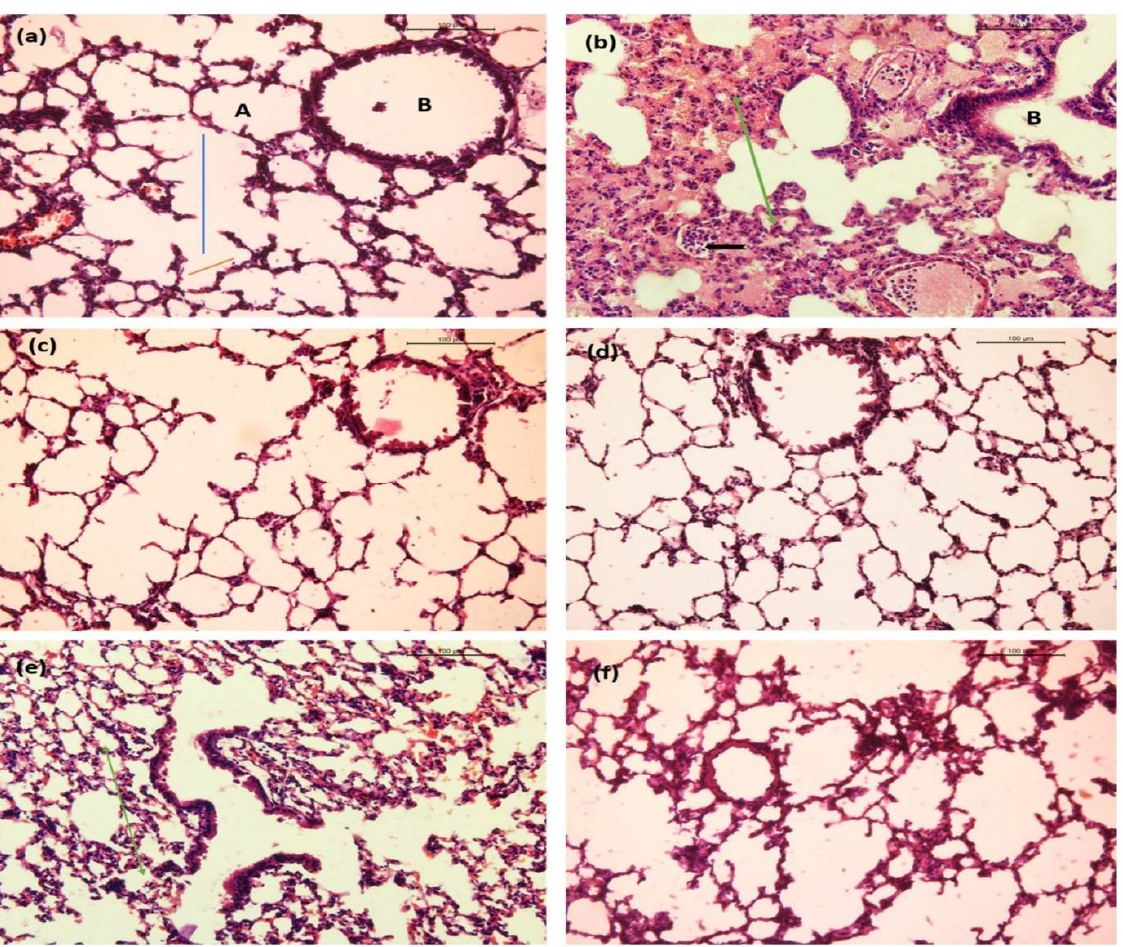
Figure 17. Images represent the BGG protection on LPS-induced sepsis model in mice. Hematoxylin and eosin (H&E)-stained lung sections from mice treated with ( a ) saline showing normal and dis- tinct respiratory bronchiole (B), alveolus (A), alveolar duct (blue line), and alveolar sac (red line). ( b ) Lipopolysaccharide (LPS) endotoxin showing severe degenerative alterations in the lung with ruptured bronchiole (B), interstitial and intraalveolar hemorrhage and alveolus atelectasis and fu- sion (green arrow), inflammatory cell infiltration (arrowhead). ( c , d ) BGG 20 mg/kg and 40 mg/kg showing no significant pathological alteration. ( e ) LPS+ BGG 20 showing moderate alveolar damage with reduction of interalveolar septum thickening (green arrow). ( f ) LPS + BGG 40 showing mild thickening of some alveolar-capillary with intact reparatory bronchiole. Scale bars: 100 μm ( f ) Meas- uring extracellular cytokine interleukins by CBA bead assay analyzed by using flow cytometry in mice serum. 2.10.4. BGG Reduces the LPS-Induced Inflammatory Response in the Sepsis Model In vivo anti-inflammatory activity of BGG was evaluated in the BALB/c sepsis model. As shown in Figure 18, the in vivo study showed a significant increase in IL-6, IFN-γ, TNFs, IL-17A, and IL-10 expression in serum of LPS (5 mg/kg)-treated mice, and no con- siderable changes in IL-2 and IL-4 levels were observed. The treatment with 20 mg/kg of BGG showed a mild decrease in IFN-γ and TNFs levels, whereas when treated with 40 mg/kg of BGG, the IFN-γ and TNFs levels showed a significant reduction in serum of previously LPS-treated mice. BGG treatment in both 20 mg/kg and 40 mg/kg concentra- tions showed a significant decrease in IL-6, IL-17A, and IL-10 levels in serum, but a 40-